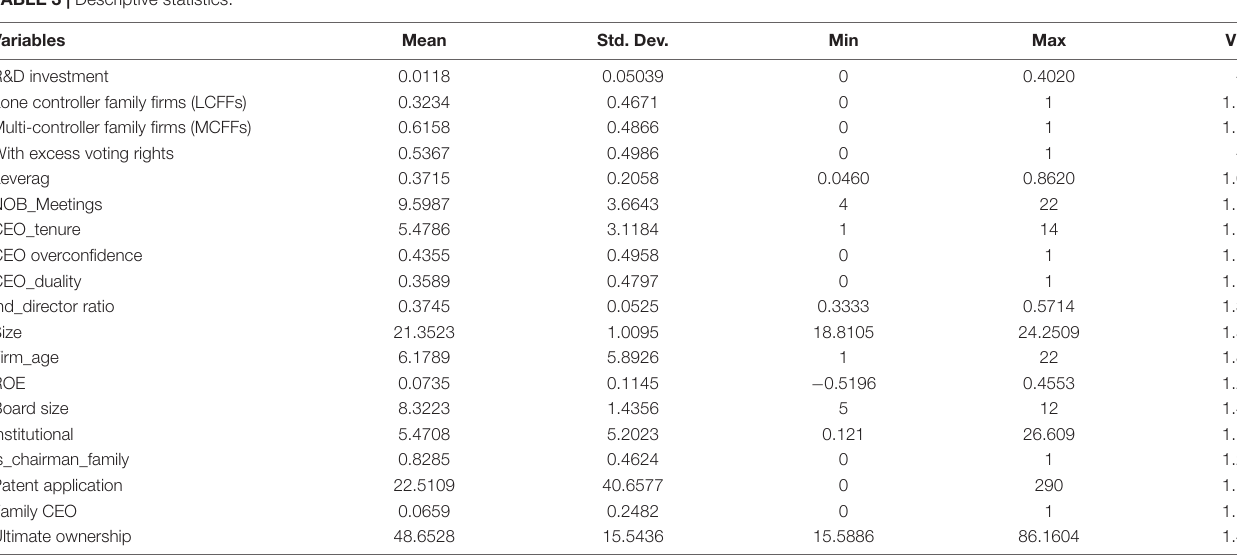
TABLE 3 | Descriptive